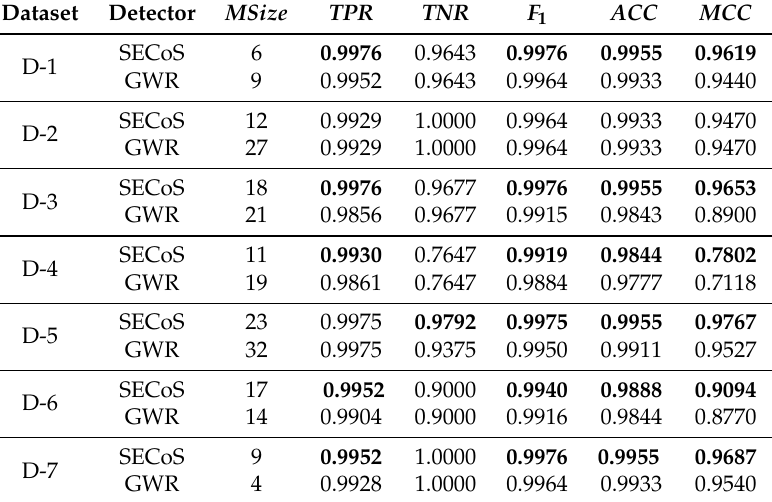
Table 7. Results in the inspection phase (unseen data) of the sample evolved detectors. Bold values indicate the best result for each metric.